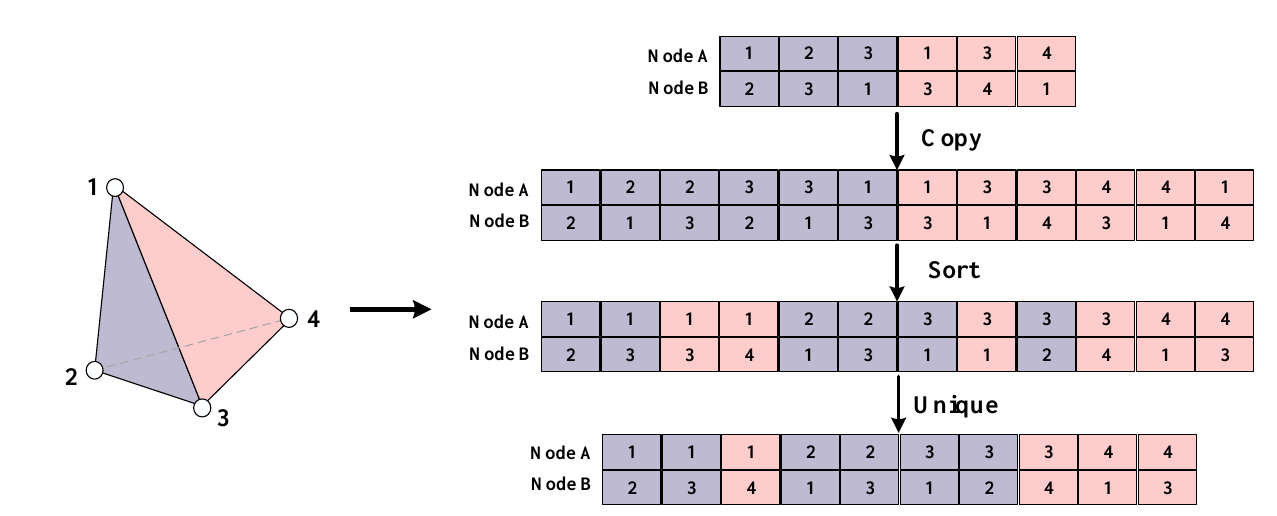
Figure 5. Illustration of searching for nodal